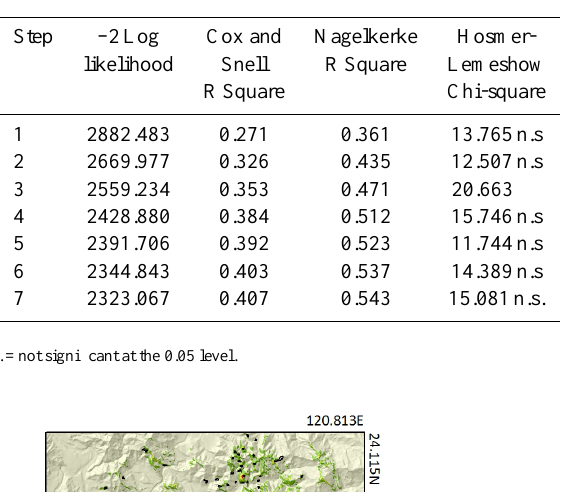
Table 3. Overall statistics of the logistic regression model.